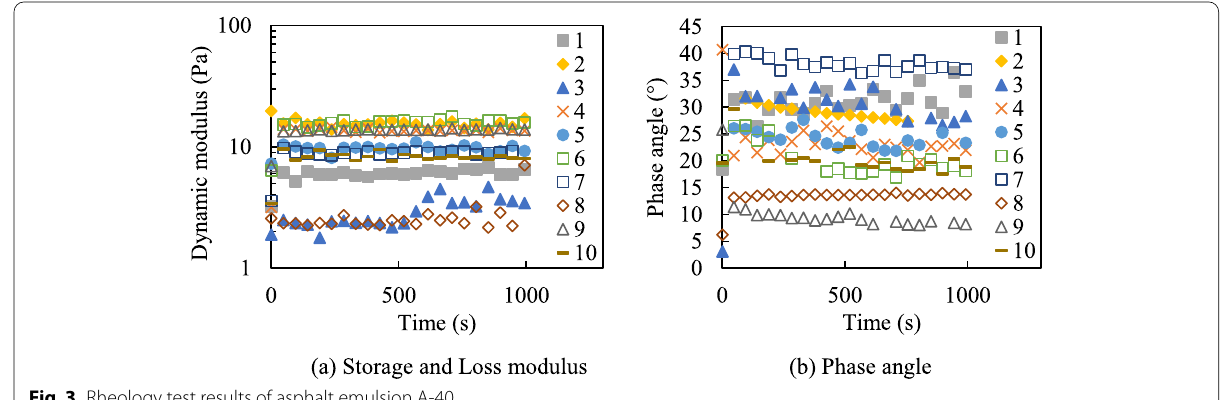
Fig. 3 Rheology test results of asphalt emulsion